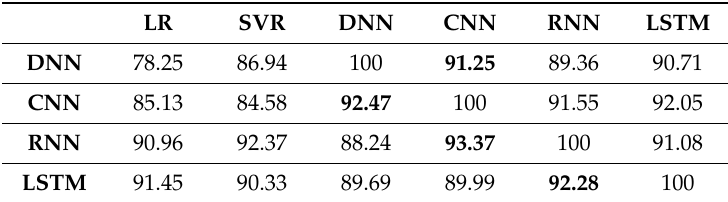
Table 5. Transferability of adversarial samples crafted by the adapted fast gradient sign method (AFGSM). The highest values are in bold